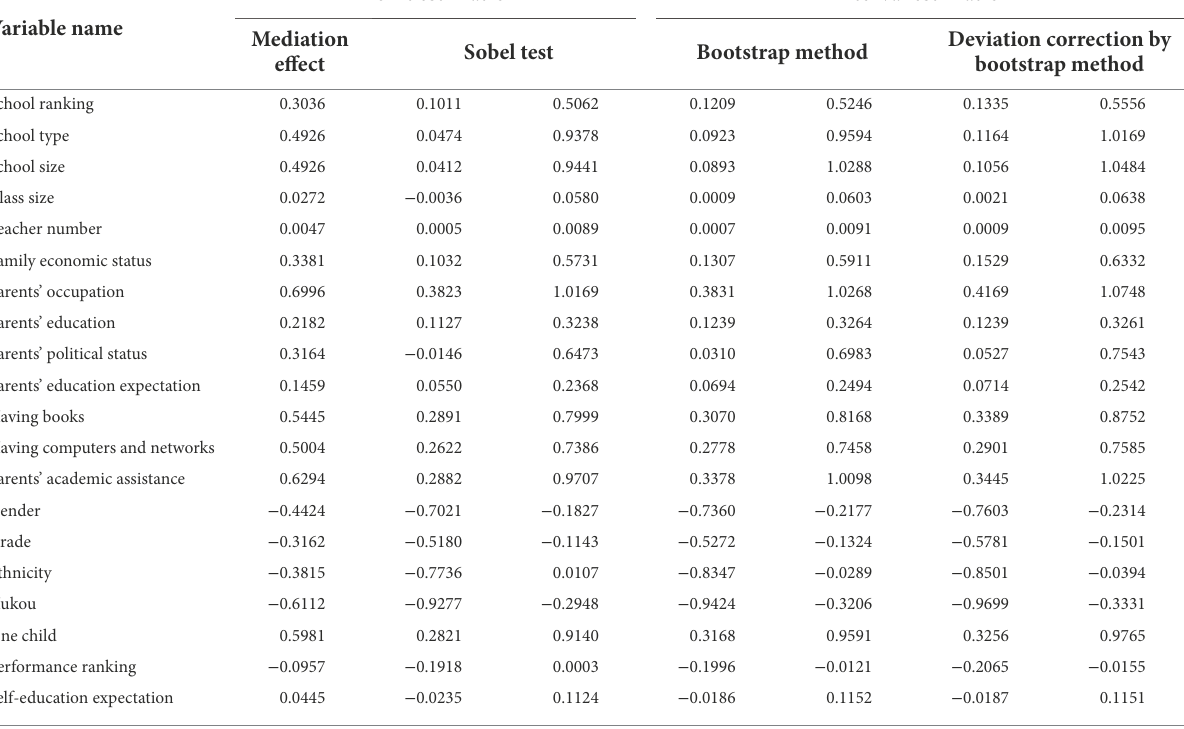
TABLE 6 Mediation effect of shadow education (English